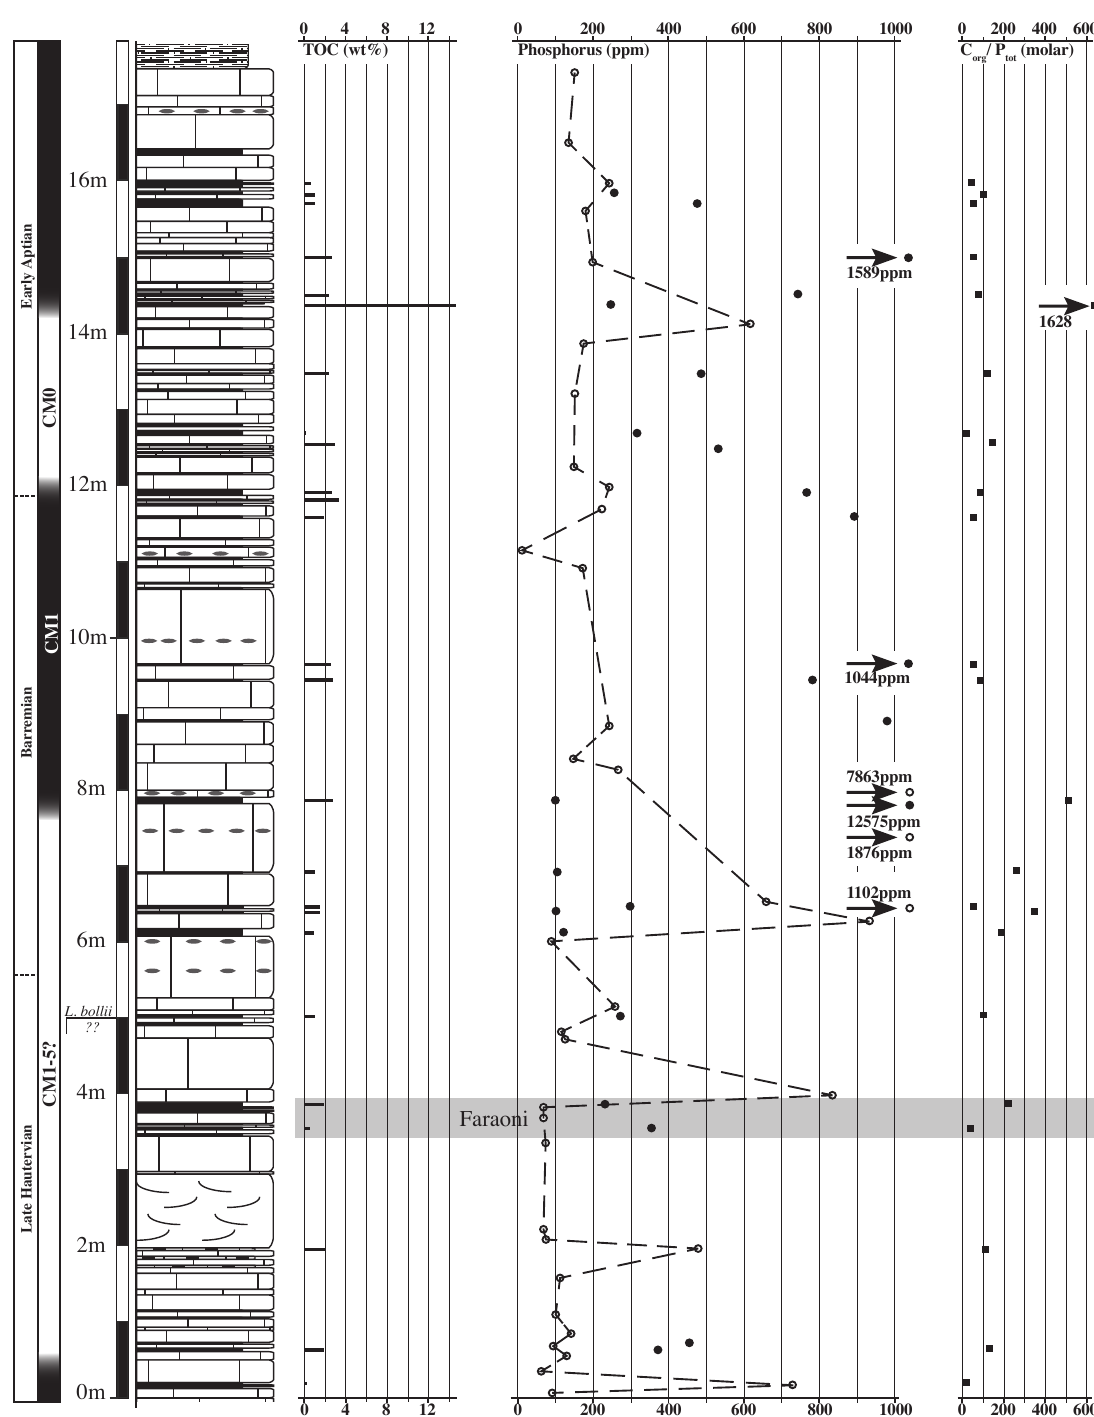
Föllmi et al., Fig. 3 Fig. 3. The Capriolo section: TOC contents in mudstone samples, phosphorus contents in carbonate (open circles) and mudstone samples (closed circles), and calculated C org :P tot molar ratios. The grey band indicates the position of the Faraoni level. The magnetostratigraphy is after Channel et al. (1987) and Channel and Erba